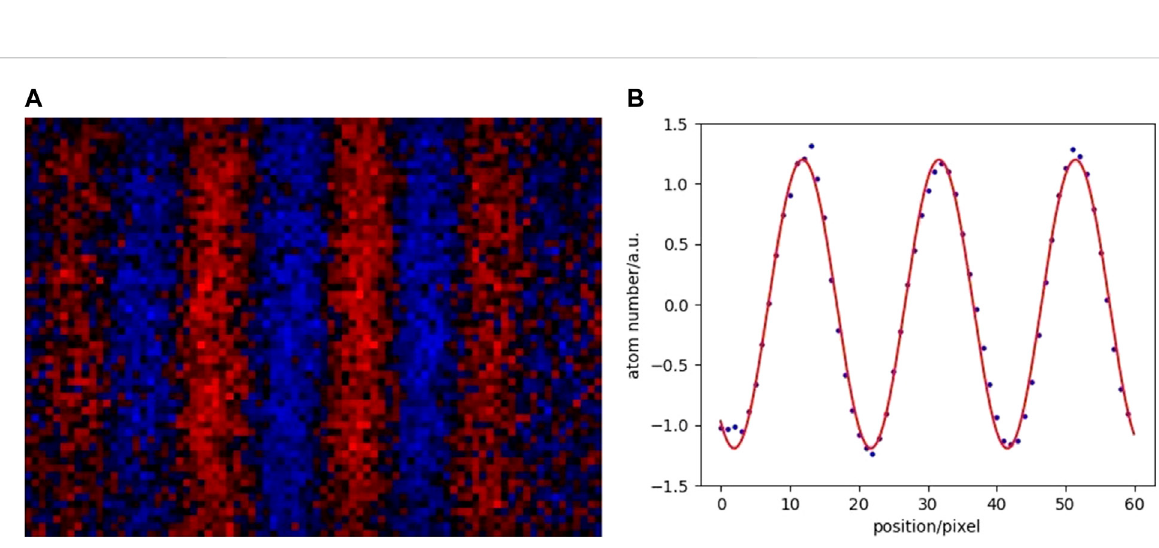
FIGURE 4 (A) Interferencefringefor2 T =2.6 sacquiredbyanEMCCD,eachpointisbinningfromeightpixels,correspondingto0.32 mminrealspace. (B) Vertical binning result after the Gaussian correction for atoms and the laser beams. The phase uncertainty of a single interference fringe is 12 mrad, which correspond to the single-shot gravity measurement resolution to be 4.5 × 10 – 11